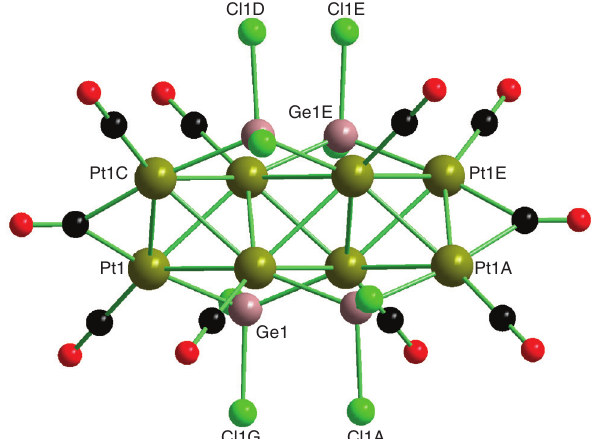
Figure 8 Simplified view of the molecular structure (diamond)